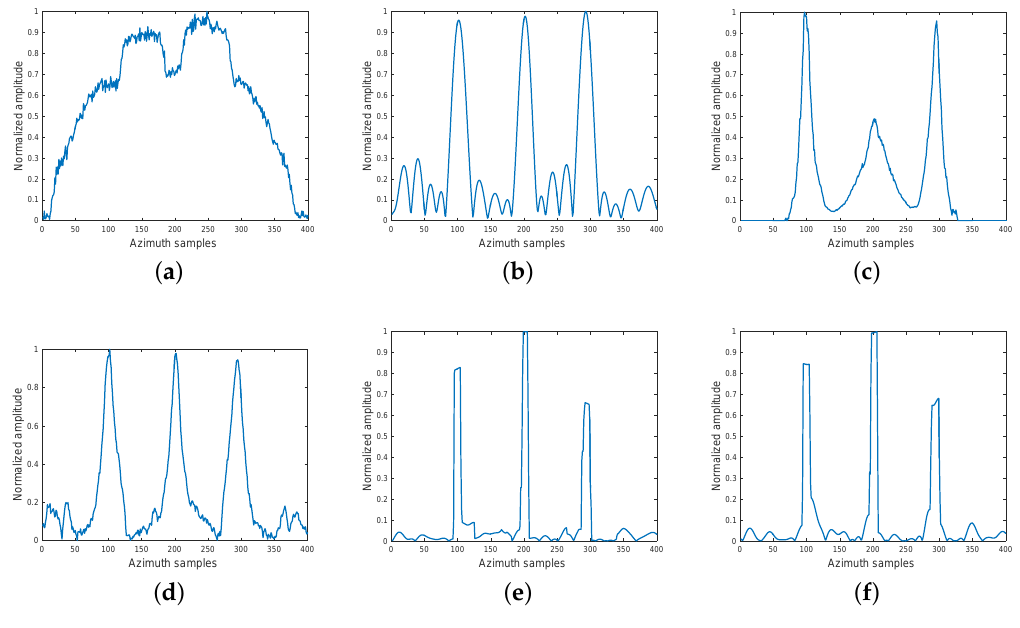
Figure 5. The profiles result of three warships below the aircraft carrier. ( a ) The echo; ( b ) The TSVD method; ( c ) The Lucy-Richardson method; ( d ) The L 2 norm regularization method; ( e ) The TV method; ( f ) The proposed FTV